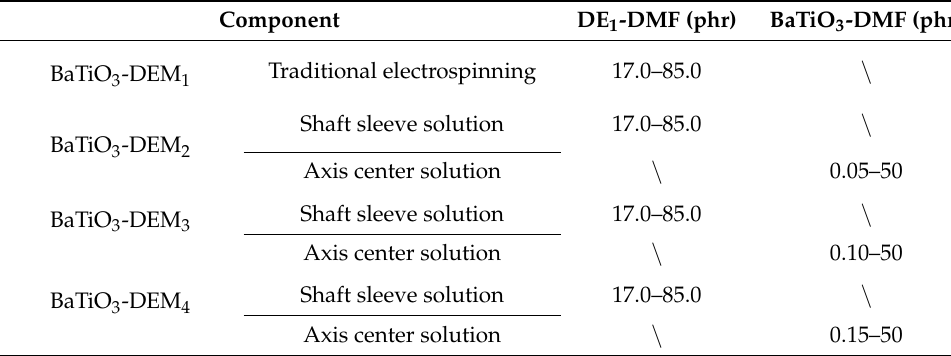
Table 4. Setting of a shaft sleeve and axial spinning solution.